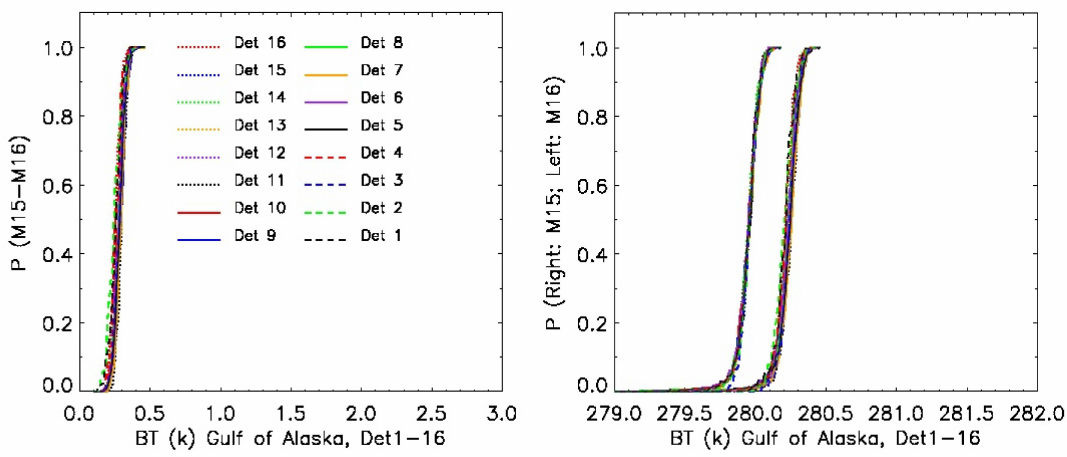
Figure 5. Cumulative histogram over the Gulf of Alaska on 20 May 2014 in M15 ´ M16 ( left ), as well as M15 and M16 ( right